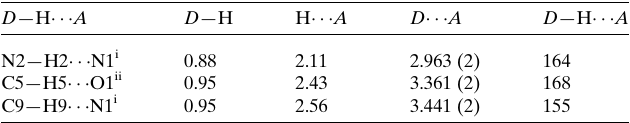
Table 1 Hydrogen-bond geometry (A˚ , (cid:2) ).